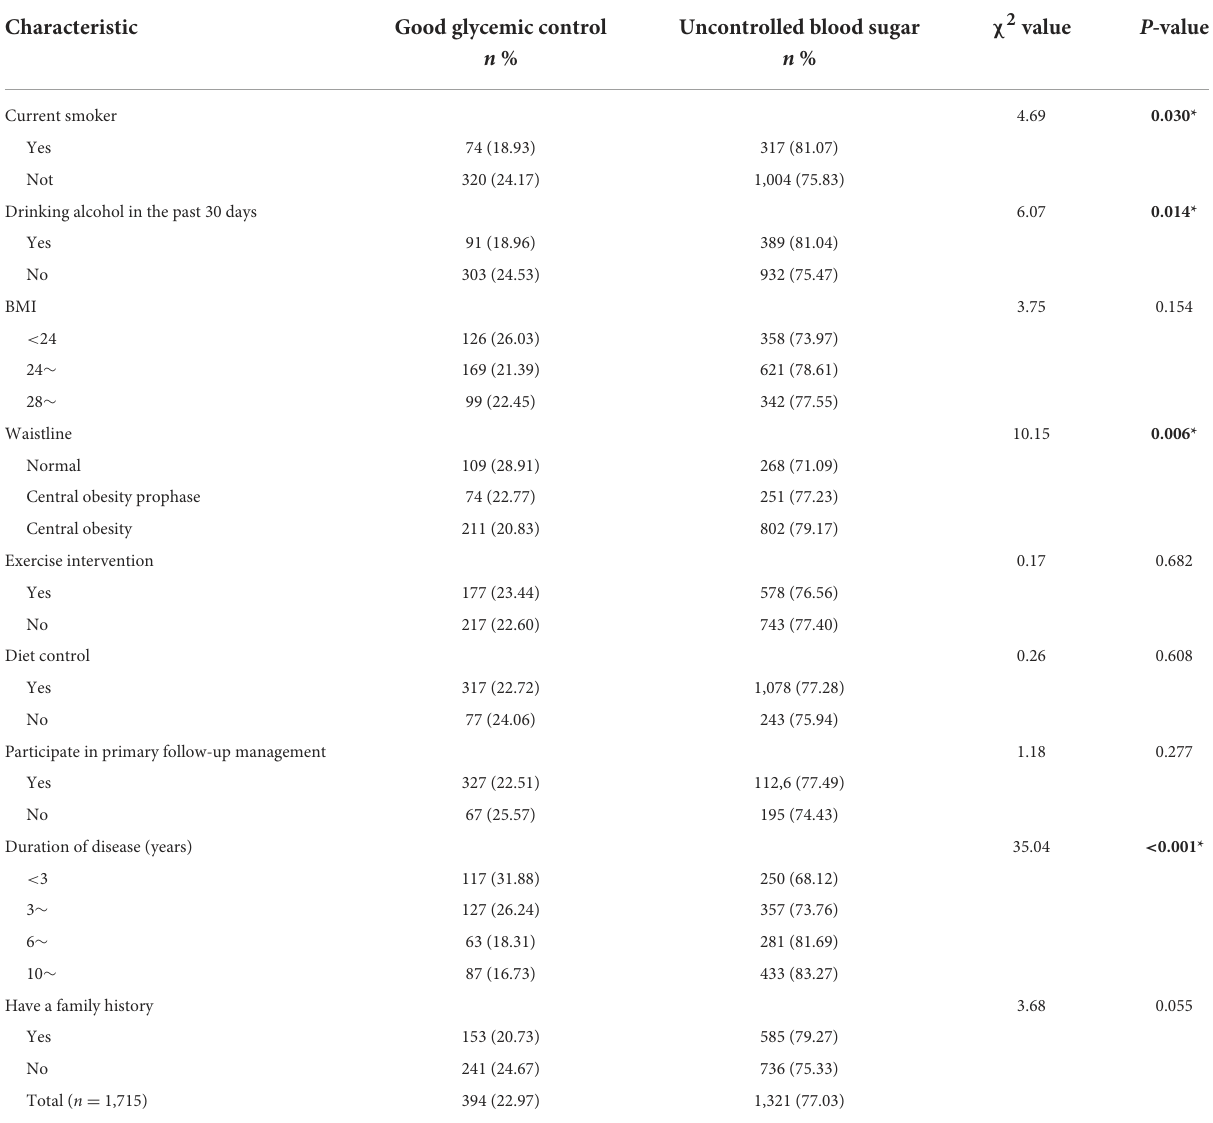
TABLE 2 The glycemic control of T2D patients with lifestyle